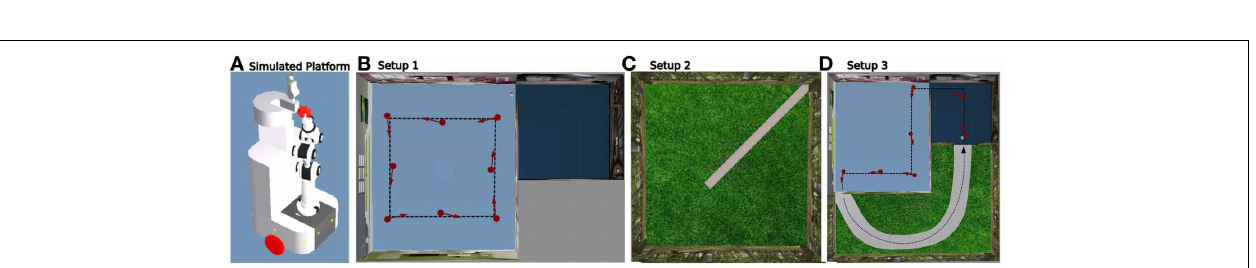
FIGURE 5 | Neural architecture relying on action selection. Down: both strategies provide an action in a field (each neuron of the field coding for a particular orientation). All action fields are merged into a dynamic neural field. This neural field provides a solution for decision making by selecting or merging actions in a robust manner (dynamic